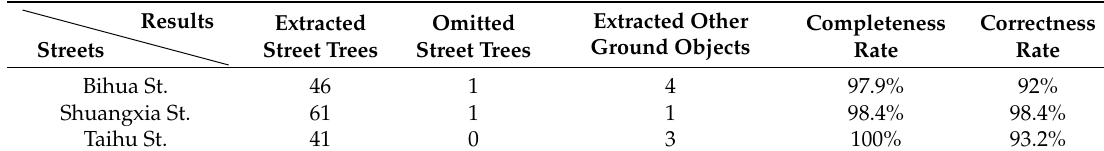
Table 5. Street trees extraction results.